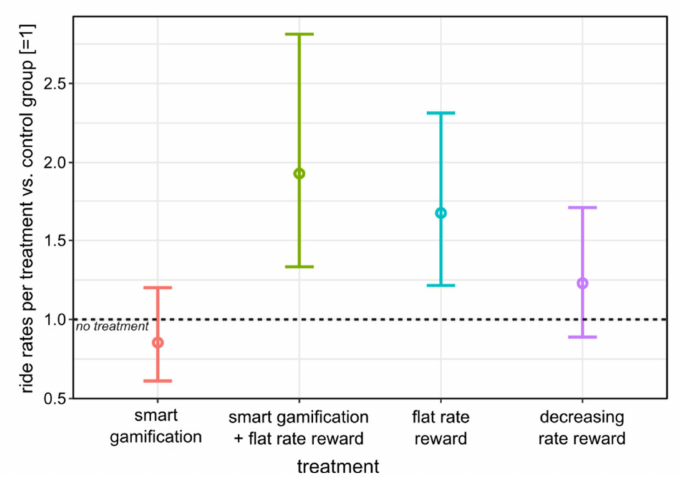
Figure 4. Predicted probabilities of the frequency of rides (vs. control group T0).